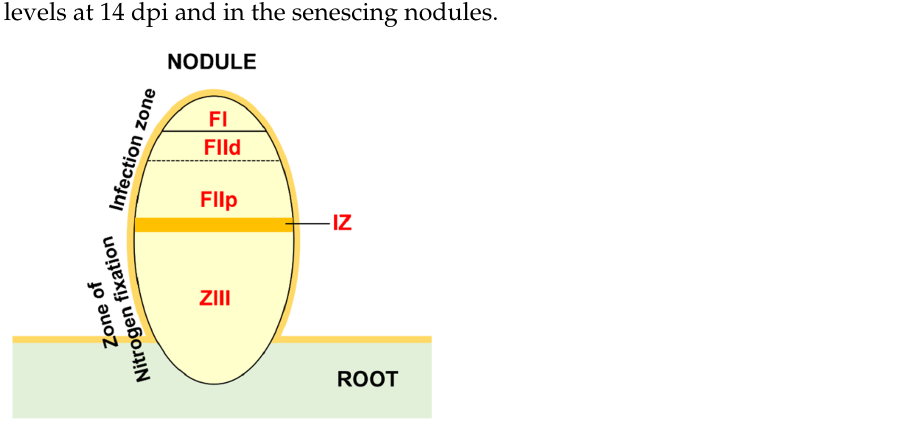
Figure 5. Schematic representation of mature root nodule with indication of the five zones that were sampled by laser capture microdissection (LCM): FI, FIId, FIIp, IZ, and ZIII.